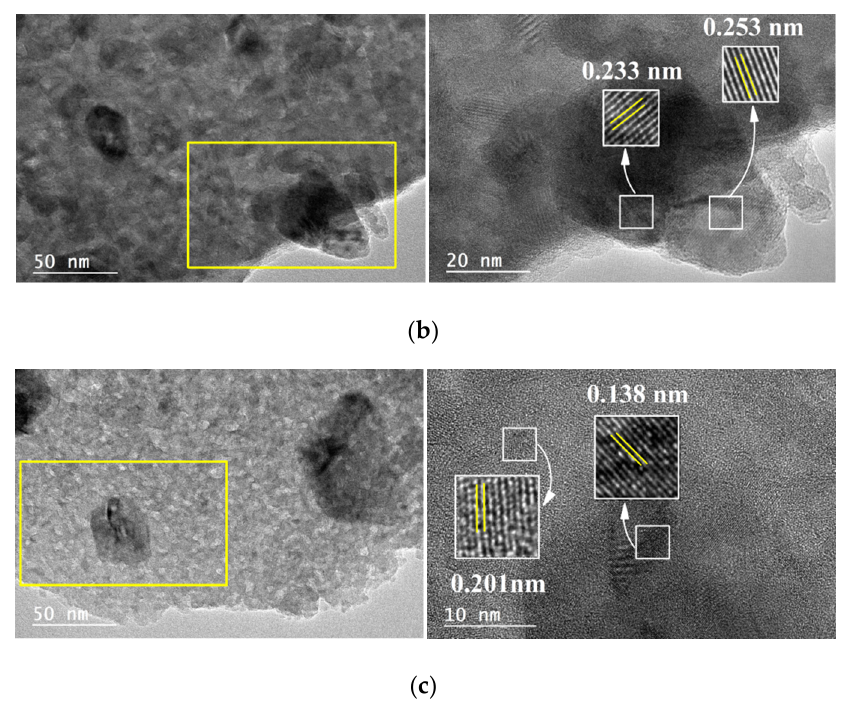
Figure 4. TEM images of the ( a ) 5Ni5CoAl, ( b ) 5Ni5CuAl and ( c ) 5Co5CuAl catalyst samples. EDX spectra and elemental compositions of the 5M5MAl samples are reported in Figure 5. The metal loadings (wt%) obtained from EDX analyses were similar to the nominal (5 wt%). Obviously, the quantitative amounts of the copper in the 5Co5CuAl and 5Ni5CuAl catalyst samples are slightly higher than the actual metal loadings, suggesting that copper species is mostly present on the catalyst surface.